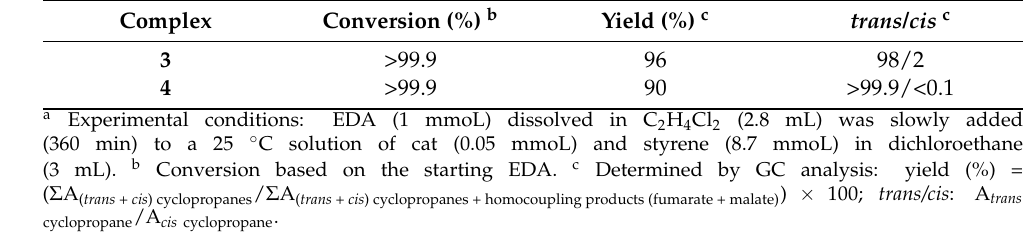
Table 6. Catalytic cyclopropanation of styrene by EDA a